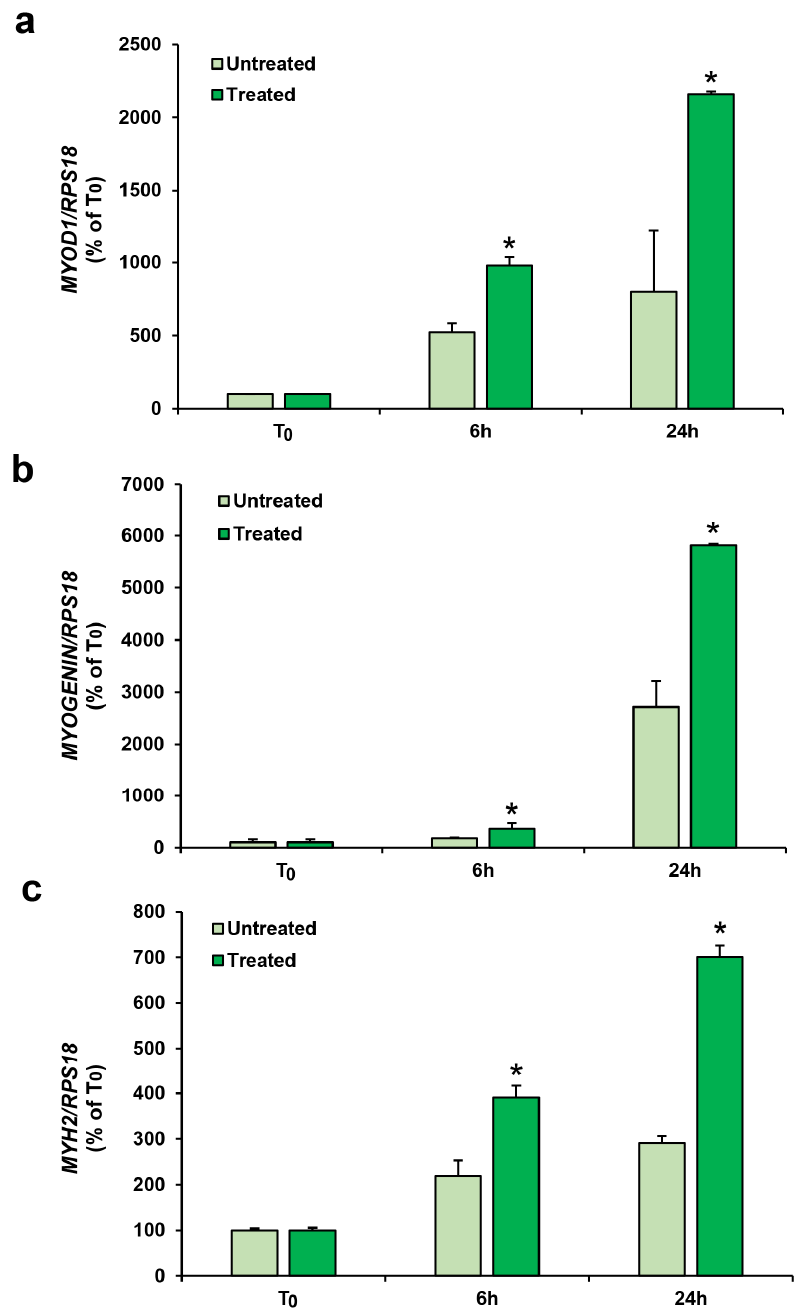
Figure 5. RealTime-qPCR gene expression analysis of MYOD1 ( a ), MYOGENIN ( b ), and MYH2 ( c ) detected during the early stages of hSC differentiation, treated or not with 10 − 7 mol/L of PTH (1-84) for 30 min. Analysis was performed on cells in growth medium (T 0 ) and after 6 and 24 h of myogenic differentiation. Values are expressed as percentage of the T 0 and are the mean ± SD of three cell lines repeated in triplicate, normalized to the housekeeping gene RPS18. ANOVA analysis with Bonferroni’s multiple comparison test. * p ≤ 0.001 versus related untreated